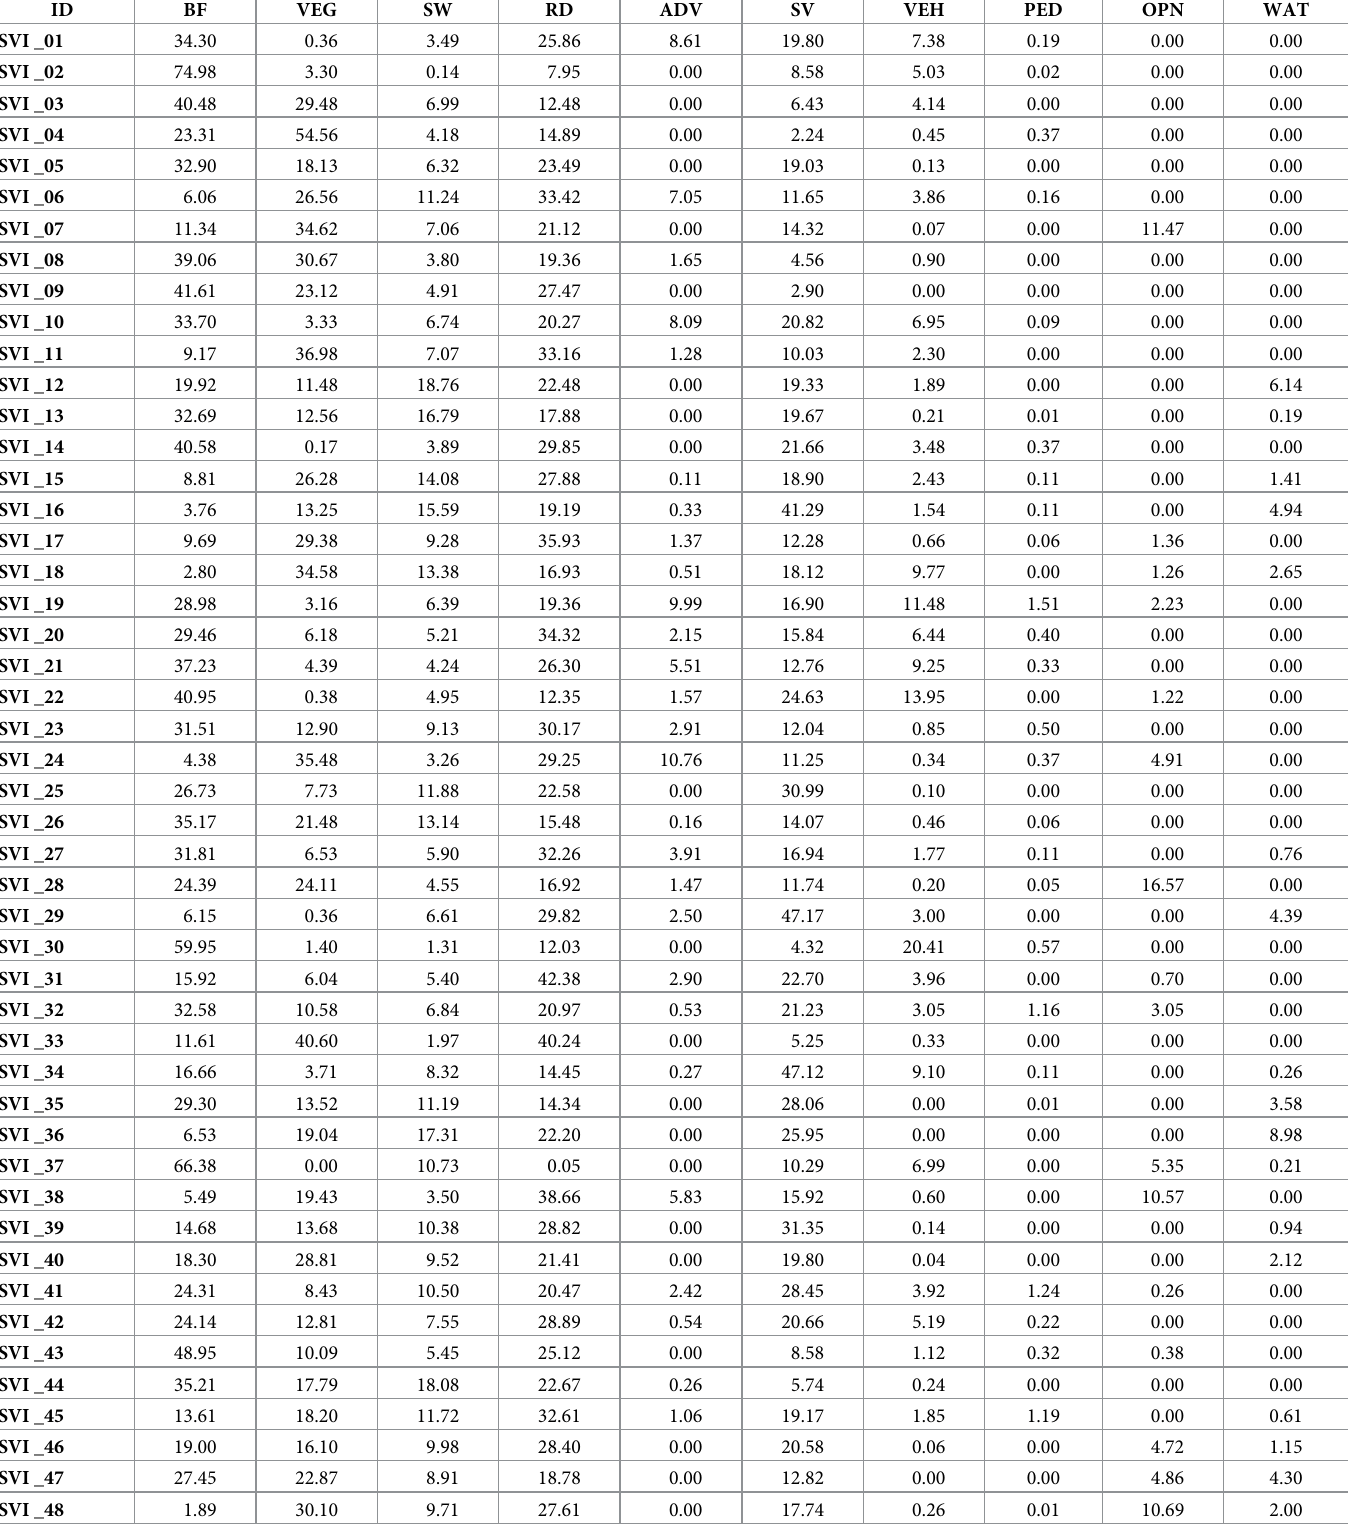
Table 1. View indices of the street elements for the selected 48 SVIs. (Values are presented as percentages).